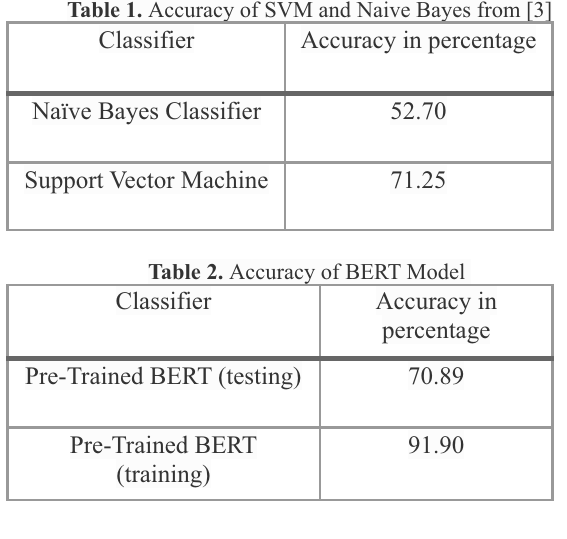
Table 1. Accuracy of SVM and Naive Bayes from [3]